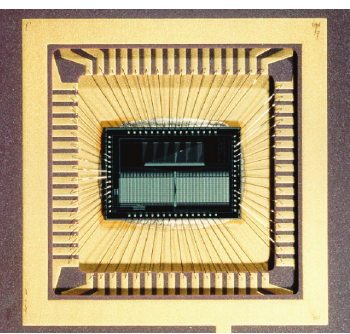
Figure 4: The optical micrograph of the prototype ANN chip that is wire-bonded to a ceramic package. The silicon chip die size is 4 . 6 mm × 6 . 8 mm